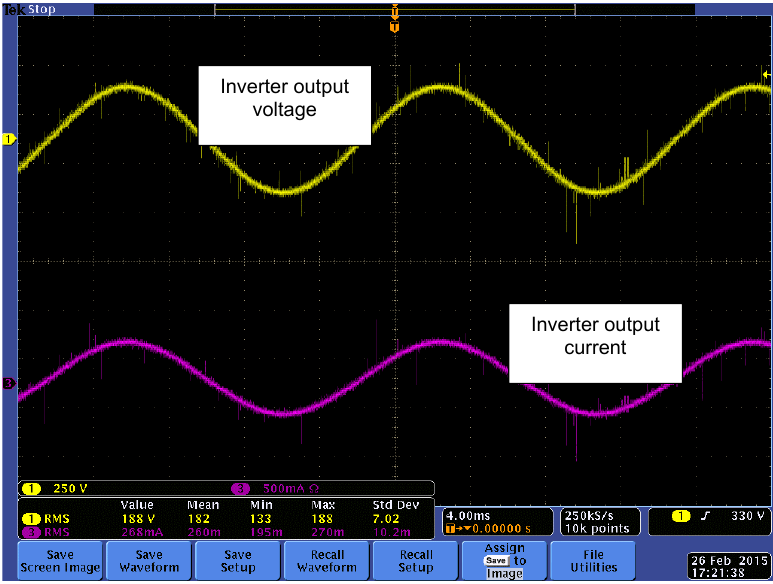
Figure 23. ML-DAB input (2L bridge) and output (5L bridge) dc current waveforms (cid:1835) and (cid:1835) . (cid:3031)(cid:3030) (cid:3121)(cid:3261)